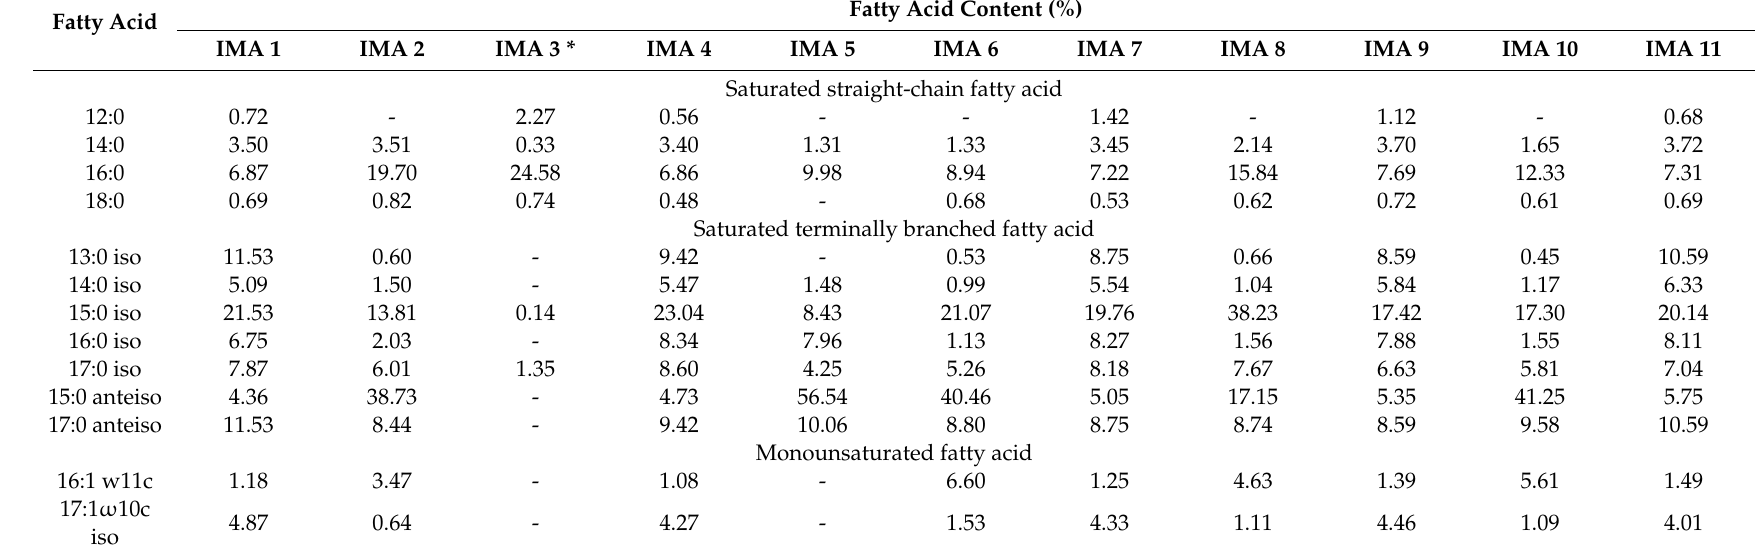
Table 2. The fatty acid compositions of eleven